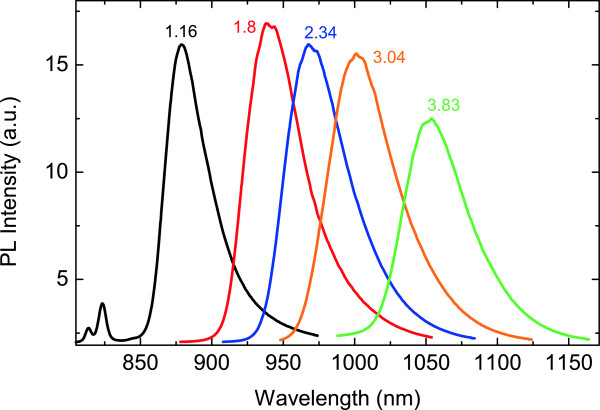
Spectral PL emission of the investigated samples at Pin = 10 mW and T = 10 K.